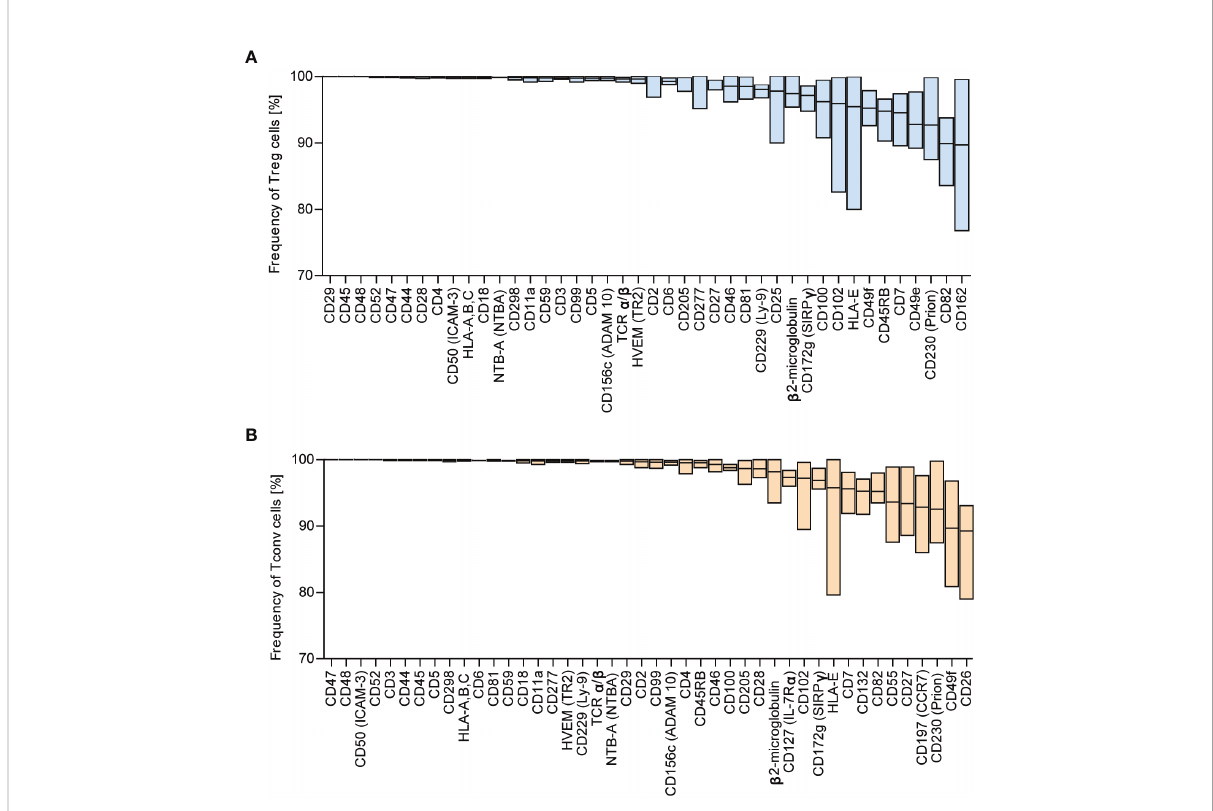
FIGURE 2 Surface markers are highly expressed across Tconv and Treg cells. Based on frequency distribution analyses, the highly expressed surface markers were identi fi ed (Figure 1B). The percent positive cells for the given marker were in the range of 88.99 – 100%. (A) Treg and (B) Tconv cells. Data are presented as fl oating bars (min to max, the line indicates mean) and show the percentage of Treg or Tconv cells positive for distinct surface markers (n=5, for both Treg and